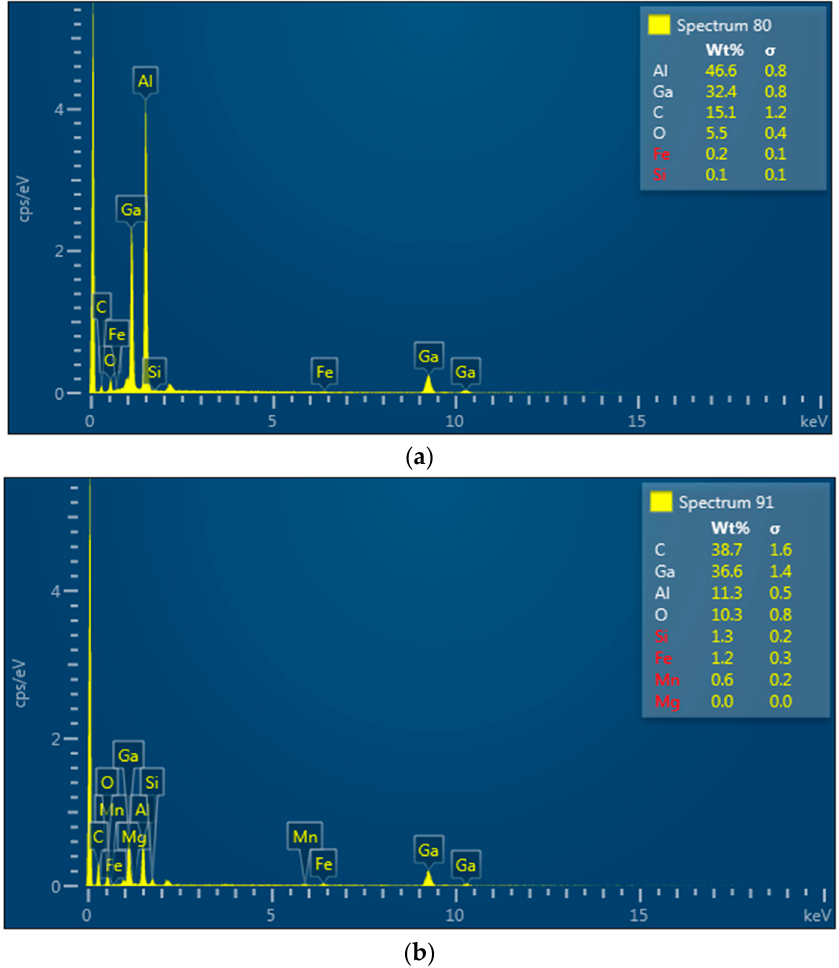
Figure 3. ( a ) Composition of elements on aluminium specimen for Al–Fe—by EDX. ( b ) Composition of elements on steel specimen for Al–Fe—by EDX .